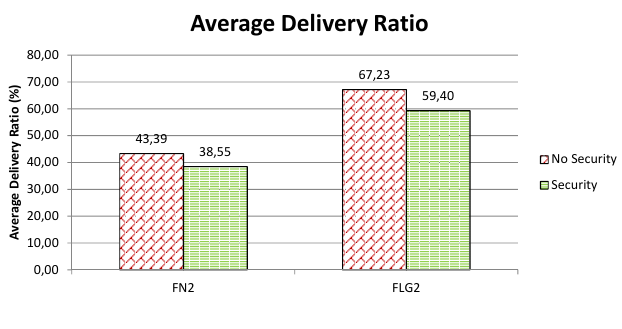
Figure 10. Average Delivery Ratio when security is enabled/disabled.